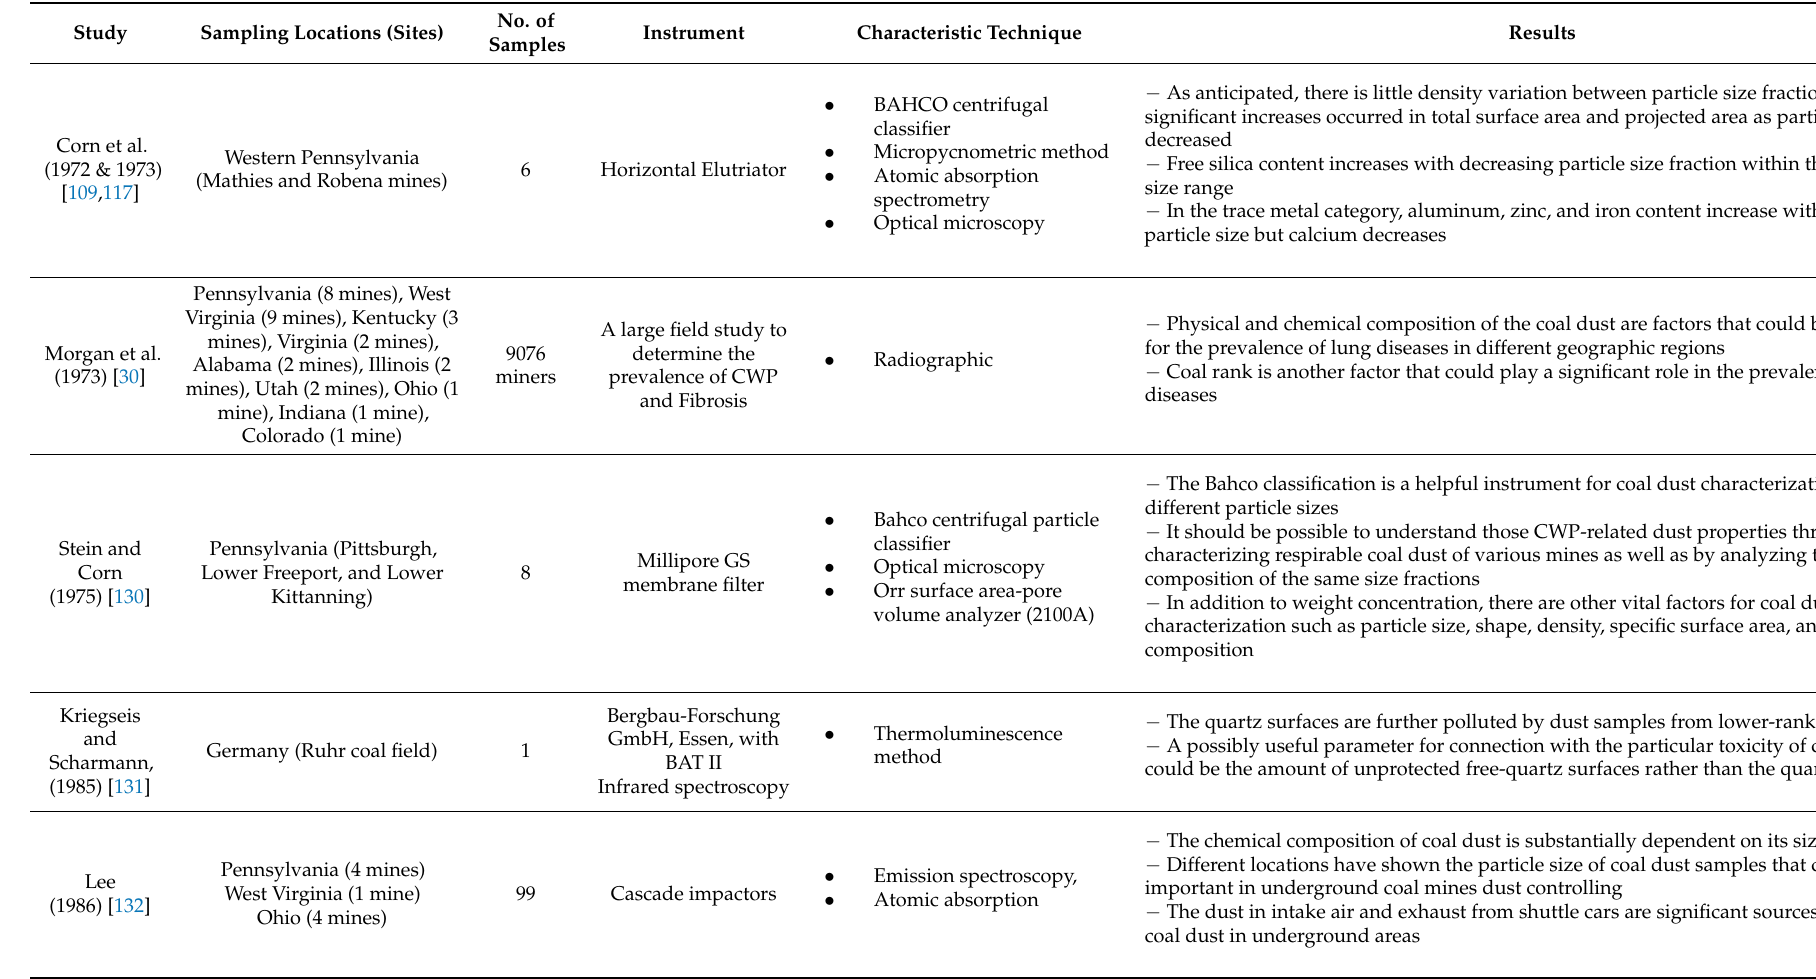
Table 4. A summary of RCMD characterization studies